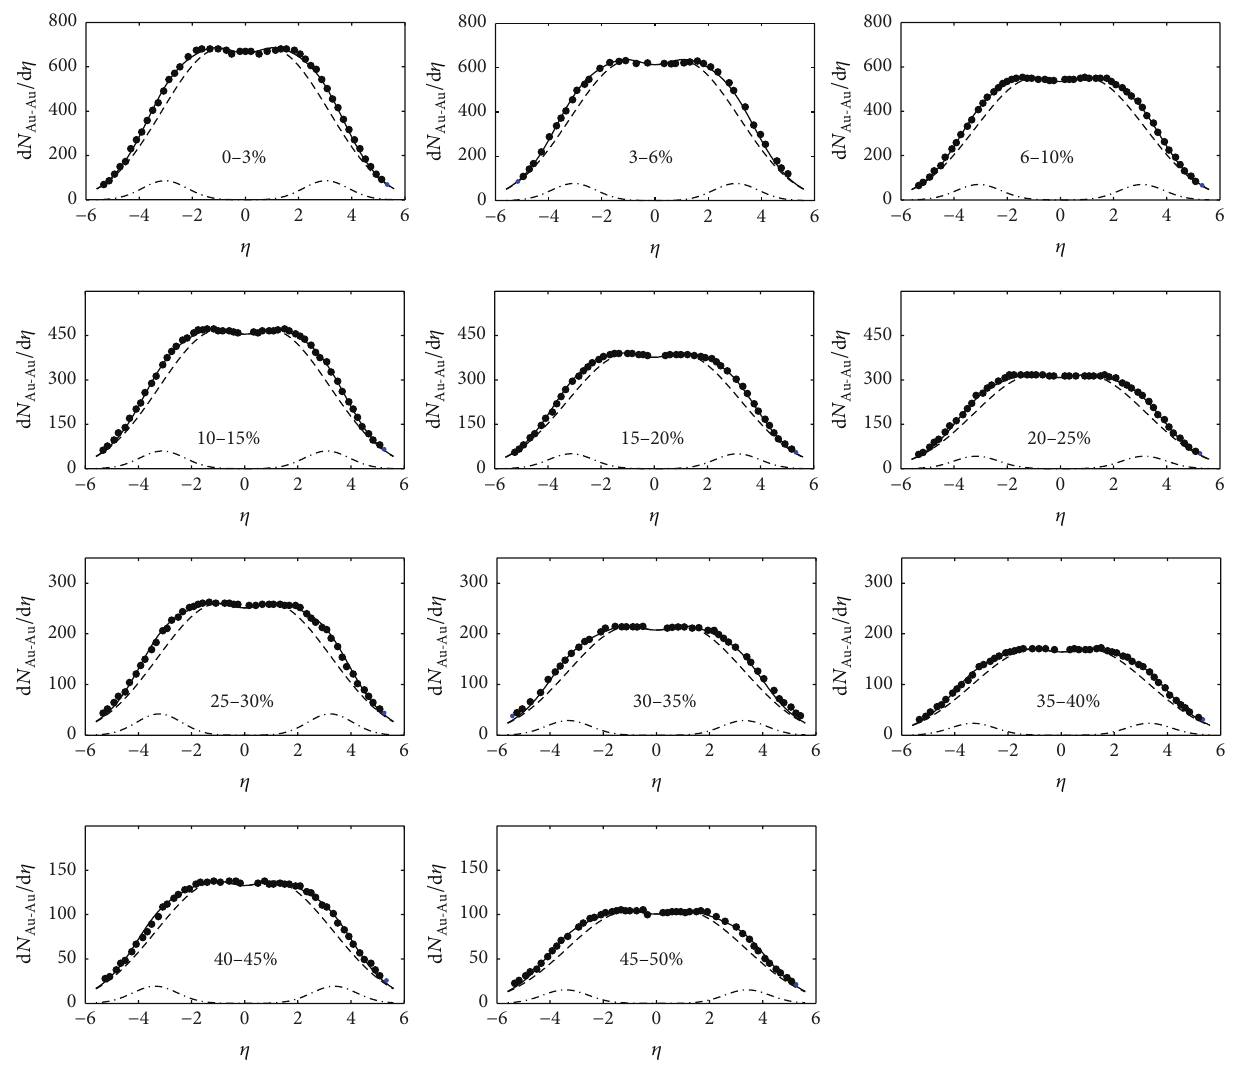
Figure 1: The pseudorapidity distributions of produced charged particles in different centrality Au-Au collisions at √𝑠 NN = 200 GeV. The solid dots are the experimental measurements [36]. The dashed curves are the results from unified hydrodynamics of (19). The dashed-dotted curves are the results from leading particles of (20). The solid curves are the sums of dashed and dashed-dotted